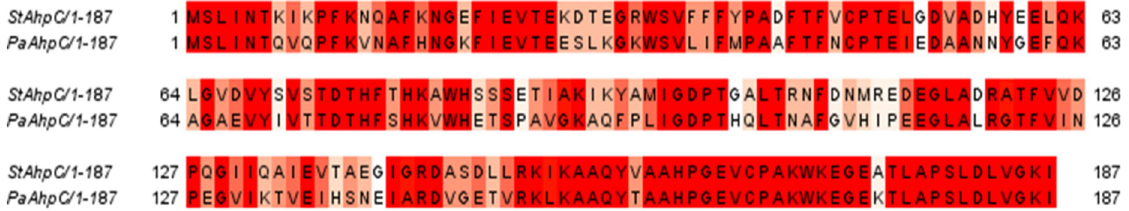
Fig 8. Alignment of the amino acid sequences of AhpCs from S . typhimurium and P . aeruginosa . The alignment of AA sequences was performed using Clustal O and the figure was generated with the Jalview. The abbreviations used and access codes for Uniprot (www. uniprot.org) are: AhpC of S . typhimurium = StAhpC (Uniprot: P0A251) and AhpC of P . aeruginosa = PaAhpC (Uniprot: Q02UU0).